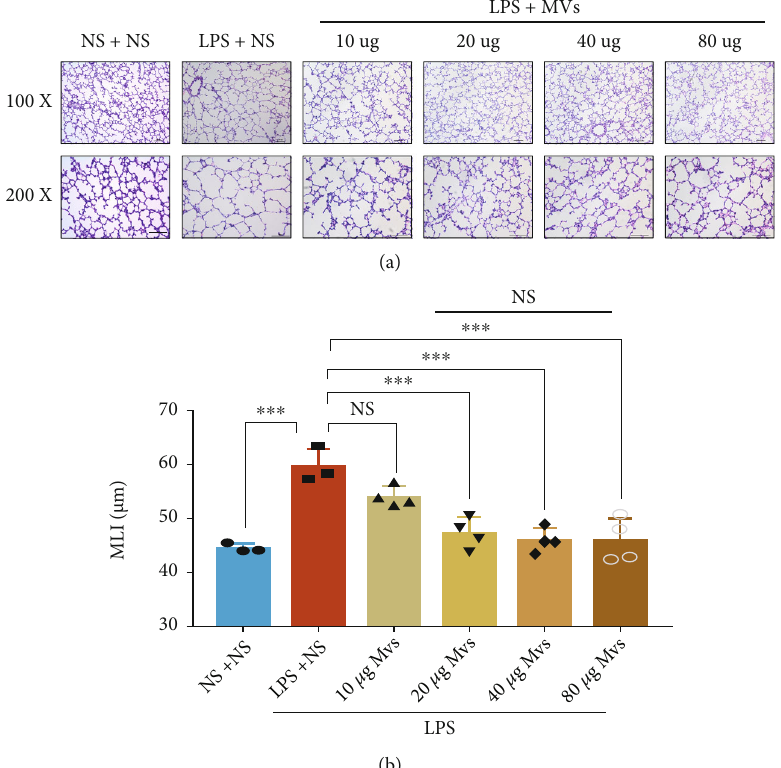
Figure 4: MVs improve antenatal LPS-induced lung injury in a dose-dependent manner. (a) Representative lung sections stained with H&E on PN14, scalebar = 100 μ m. (b) Quanti fi cation of the MLI ( N = 3 ‐ 4 , ANOVA, NS: not signi fi cant, ∗∗∗ P < 0 : 001